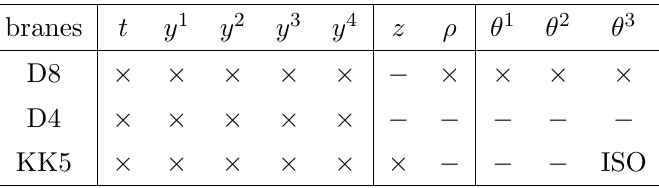
Table 2 . The brane picture underlying 5d N = 2 SCFT’s de(cid:12)ned by the D4-D8-KK5 system. The system is BPS = 4 and in the AdS 6 (cid:2) S 4 = Z k vacuum the AdS radial coordinate is represented by a combination of (cid:26) and z , while the Z k orbifold is realized by the KK5